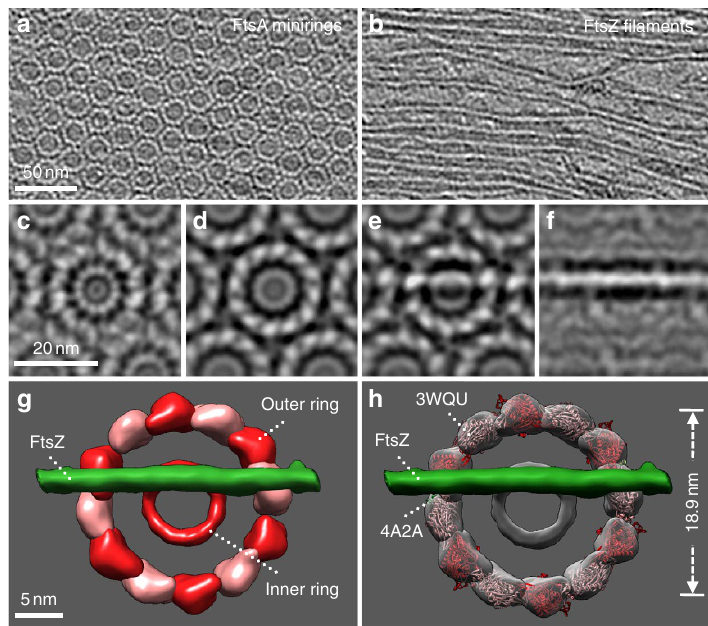
Figure 5 | Tomography and structural modelling of FtsZ protofilaments aligned on top of FtsA minirings on lipid monolayers. ( a , b ) Two tomographic slices of the same transmission electron microscopy (TEM field), from the lipid monolayer upward, showing a FtsA miniring hexagonal array ( a ), then aligned unbundled FtsZ protofilaments on top of the array ( b ) (see also Supplementary Movie 1). ( c – f ) A subvolume-averaged portion of a field from ( a , b ), with tomographic slices from the lipid monolayer ( c ) up to FtsZ filaments ( f ). ( g ) Segmentation of the 3D reconstructions showing potential sites of interaction where an FtsZ filament (green) intersects with the FtsA miniring (red and pink subunits). ( h ) Atomic structures from S. aureus FtsA (3WQU) are shown docked into the miniring densities, along with the FtsA-binding peptide from the C terminus of FtsZ (4A2A) (green) into the two subunits interacting with the crossing FtsZ protofilament. See also Supplementary Movie 2. For simplicity, the other 10 FtsZ C-terminal peptides are not